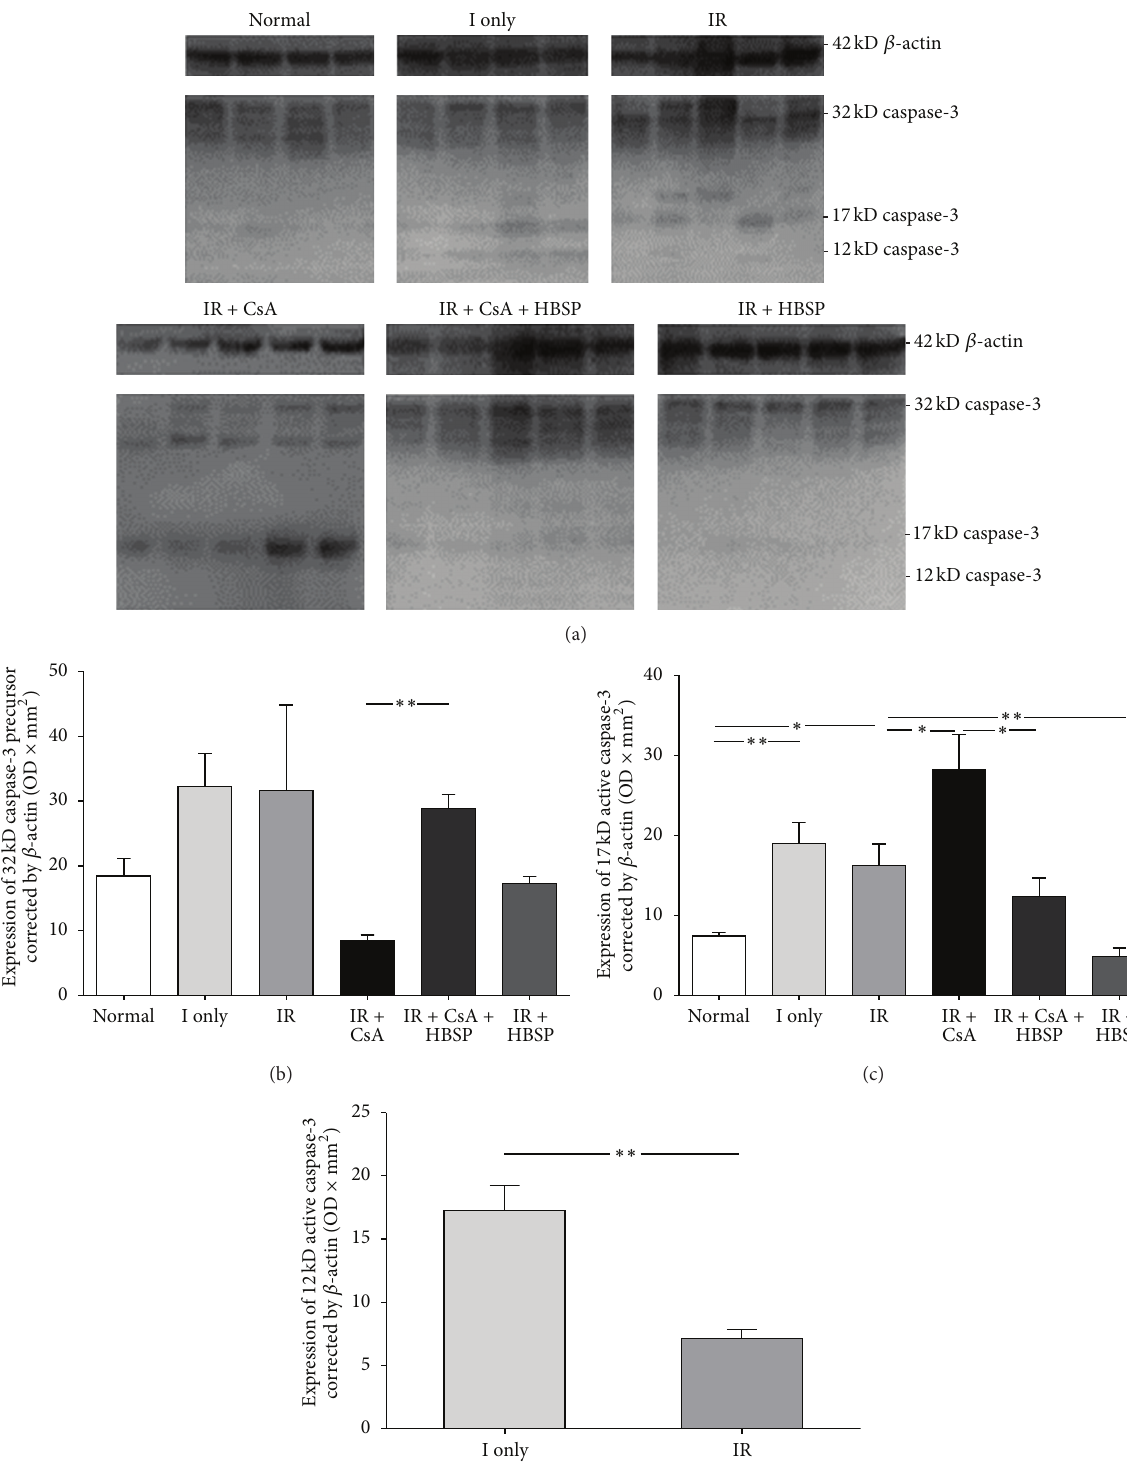
Figure 7: The expression of caspase-3 protein was measured by western blot (a). There was much more 32kD precursor transformed to active subunits in the IR + CsA kidneys than that in the normal, ischemia only, or IR kidneys (b) but this was reversed by HBSP treatment. The expression of 17kD active caspase-3 was upregulated by IR and furthered by CsA decreased by HBSP (c). Another active subunit of 12kD caspase-3 was predominantly expressed in the ischemia only kidneys, which was decreased after reperfusion in the IR kidneys (d). Data are expressed as the volume density corrected against the loading control of 42 kD 𝛽 -actin (mean ± SEM; 𝑛 = 6 ). ∗ 𝑃 < 0.05 ; ∗∗ 𝑃 < 0.01